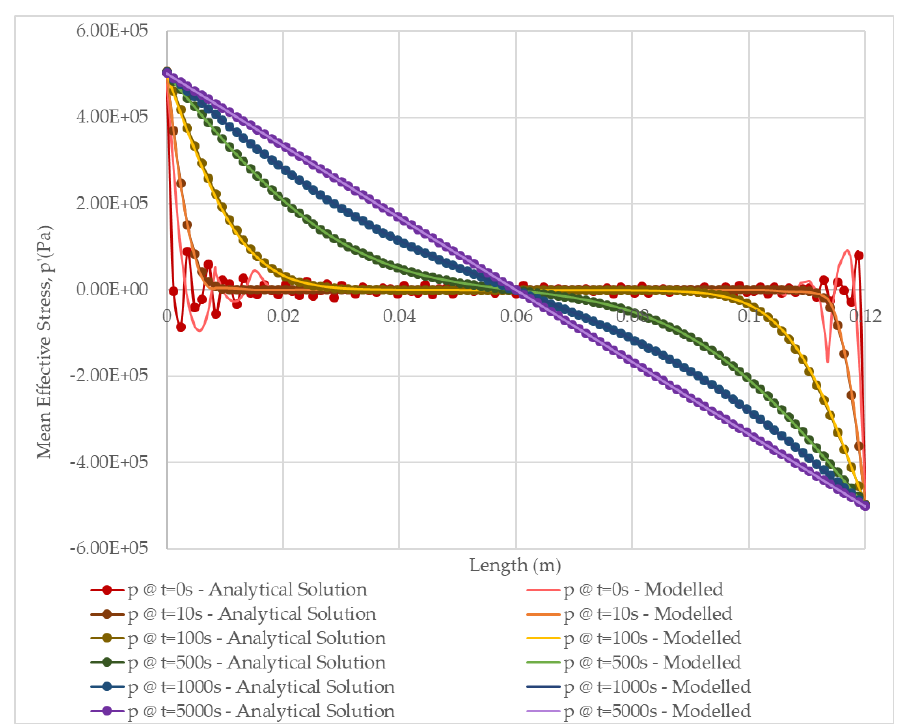
Figure 9. Verification study — 1D transient solution results for mean effective stress over the length of the specimen.